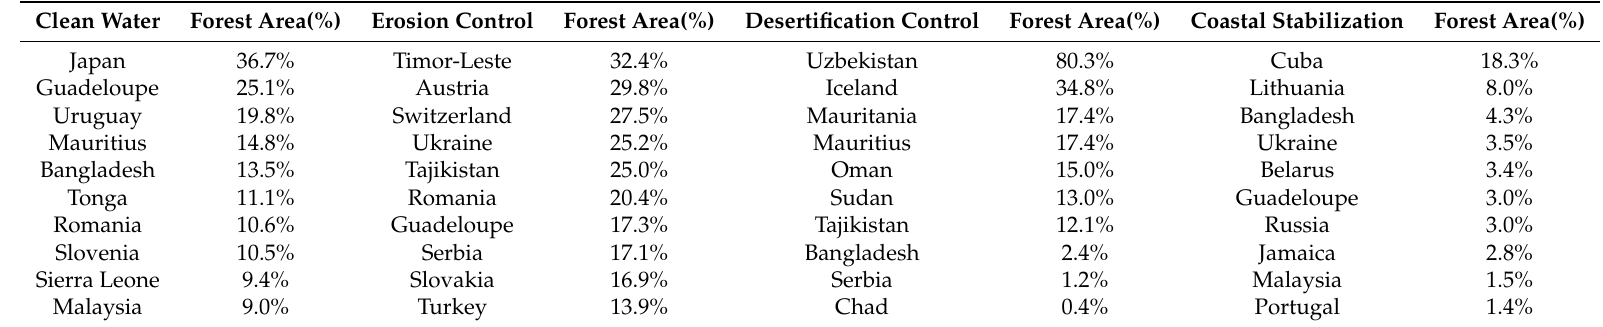
Table 5. Top countries with soil and / or water protection as a primary management objective. Source: FAO 2015 and FAO